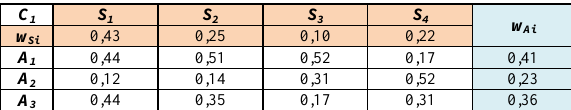
Table 7. Table of the weights of the alternatives associated